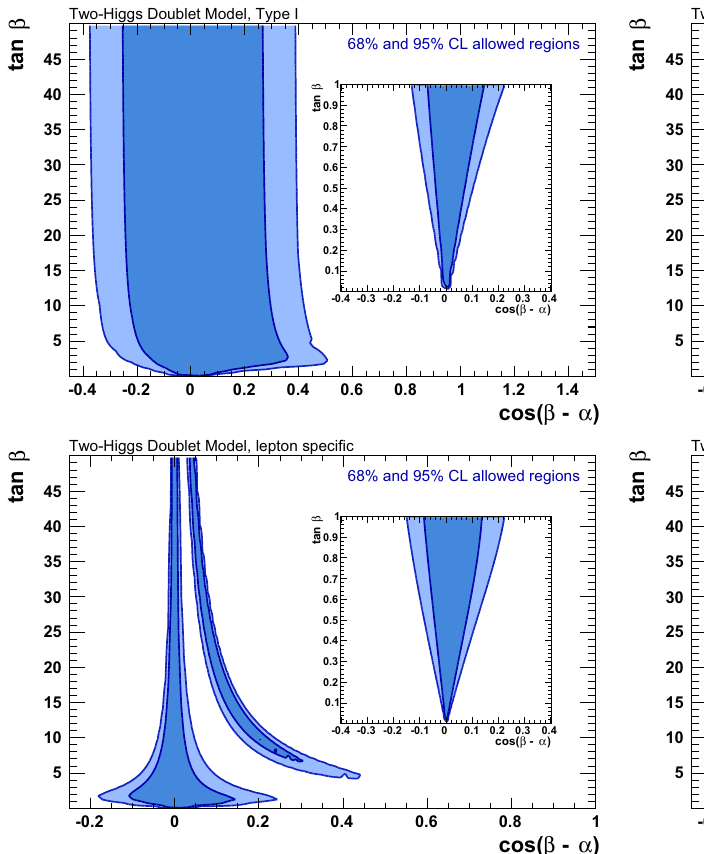
Fig. 8 Results from 2HDM fits using the ATLAS and CMS combined Higgs coupling strength measurements. Shown are allowed parameter regions (68 and 95% CL) for the four 2HDM scenarios from scans of